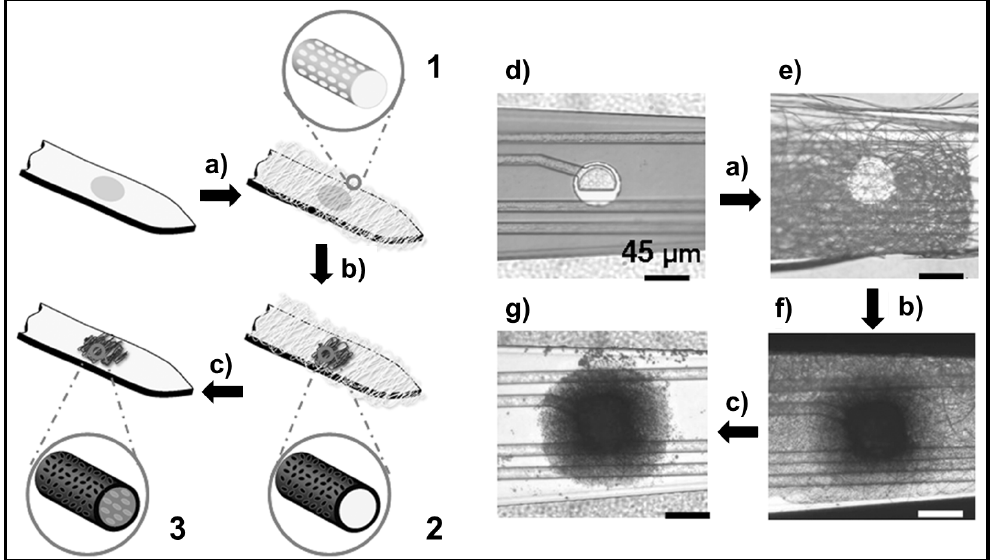
Figure 26. Schematic illustration of conducting polymer (PEDOT) nanotube fabrication on neural microelectrodes: ( a ) Electrospinning of biodegradable PLGA template fibers with well-defined surface texture ( 1 ); ( b ) Electrochemical deposition of conducting polymer (PEDOT) around the electrospun fibers ( 2 ); ( c ) Dissolving the electrospun core fibers to create conducting polymer nanotubes ( 3 ); Optical microscopy images of ( d ) the entire microelectrode site before surface modification; The electrode site ( e ) after electrospinning of PLGA nanofibers; ( f ) After electrochemical deposition of PEDOT; and ( g ) After removing the PLGA core fibers. Reprinted with permission from [116]. Copyright 2006 WILEY-VCH Verlag GmbH & Co.